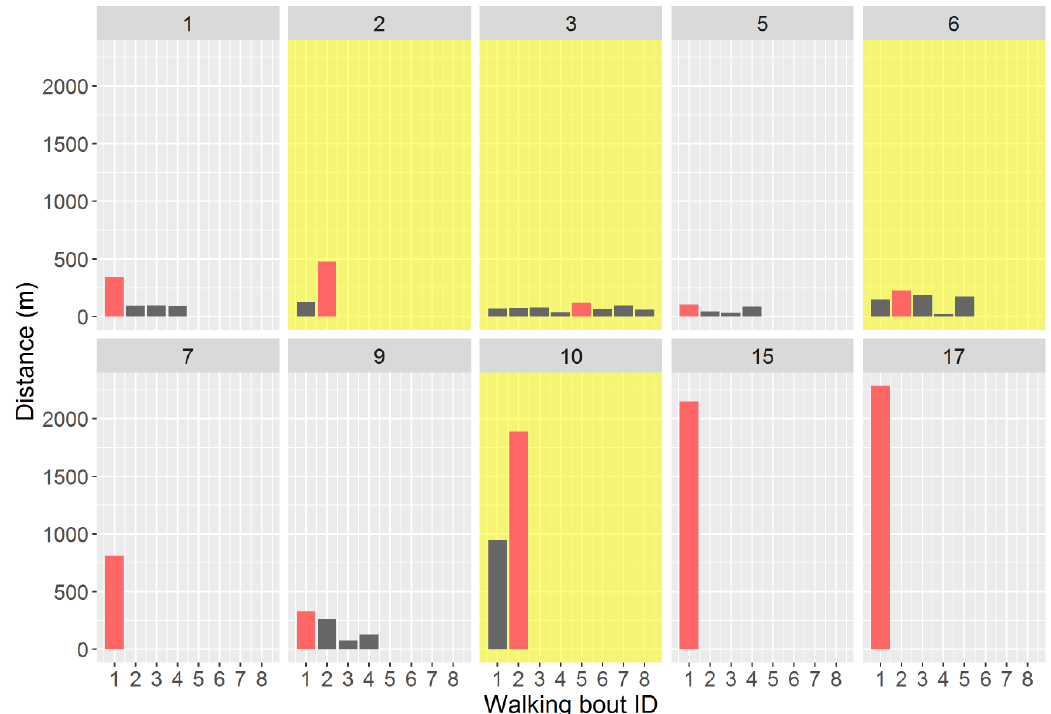
Figure 4. The symptom-limited walking distances performed during the walking bouts for each of the 10 participants who had to stop walking during the outdoor walking session. In a given panel, the red bar depicts the greatest distance performed over a walking bout during the session. The yellow panels highlight the participants who performed their greatest walking distance during the second or a subsequent walking bout.